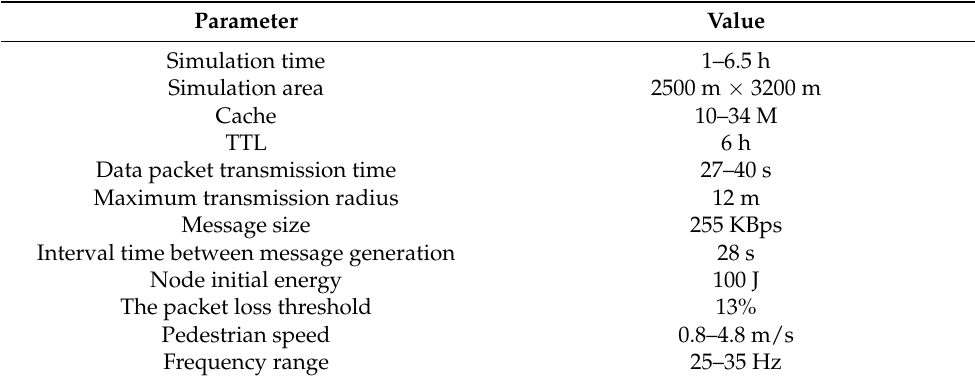
Table 1. Experimental parameters setting.